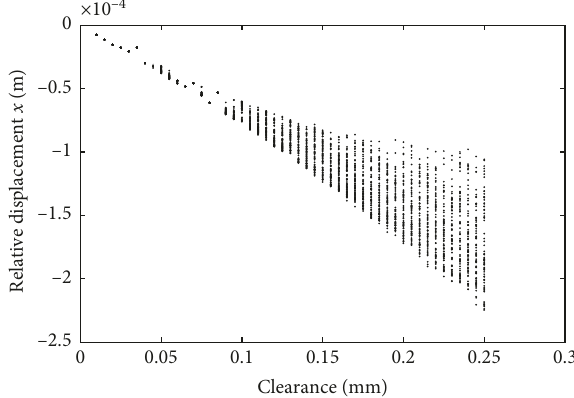
Figure 13: Bifurcation diagram with varying the